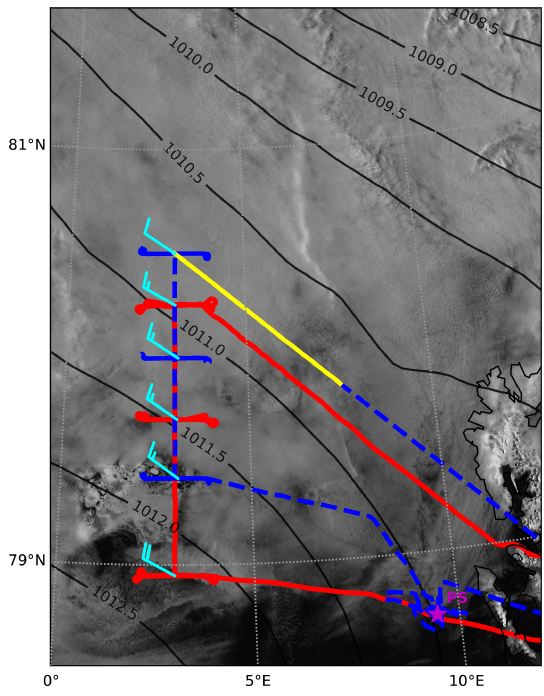
Figure 11. Tracks of Polar 5 (blue) and Polar 6 (red) on 20 June 2017 overlaid over the corresponding MODIS image. The yellow line refers to the Polar 5 descent shown in Fig. 12.